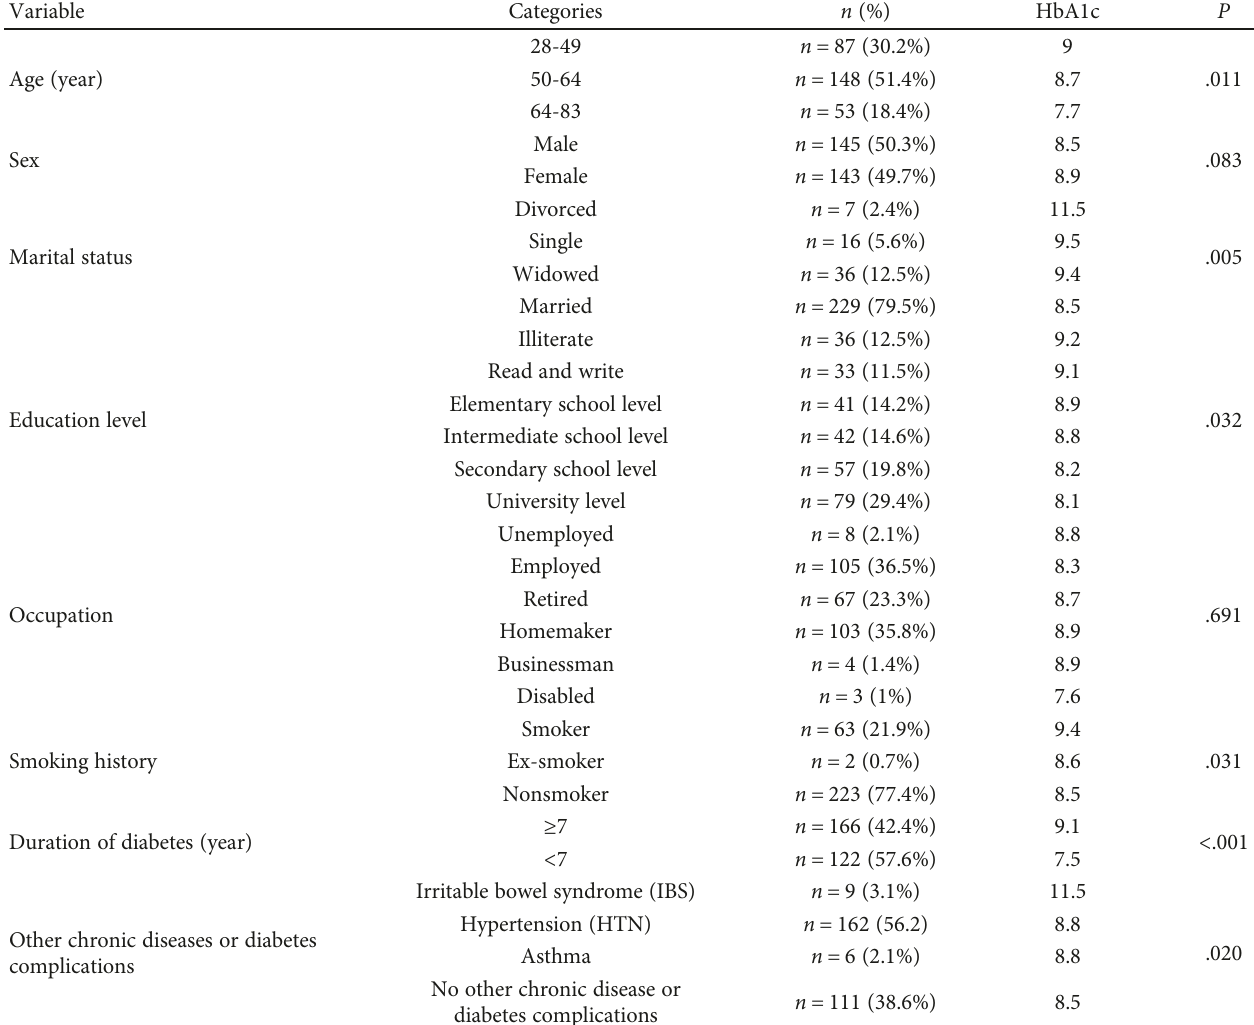
Table 1: Sociodemographic and health risk